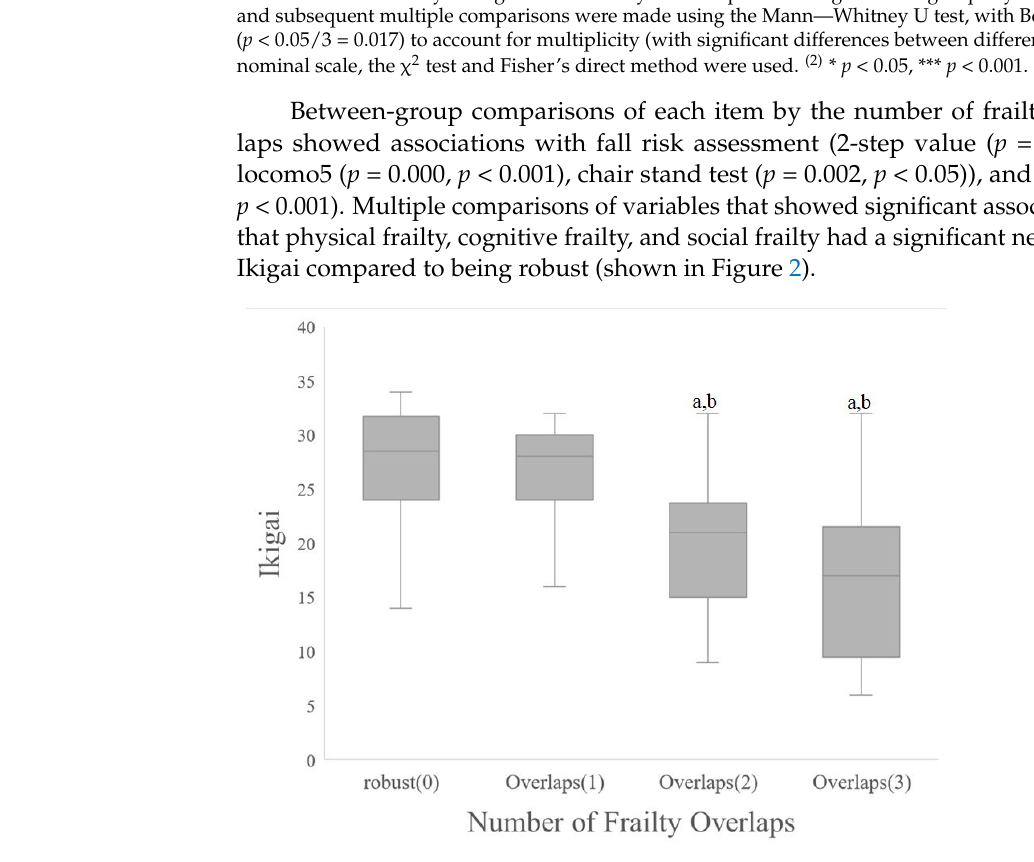
Figure 2. Comparison of life fulfillment by number of frailty overlaps. (a) p < 0.001 vs. robust(0); (b) p < 0.001 vs. Number of Frailty Overlaps(1).